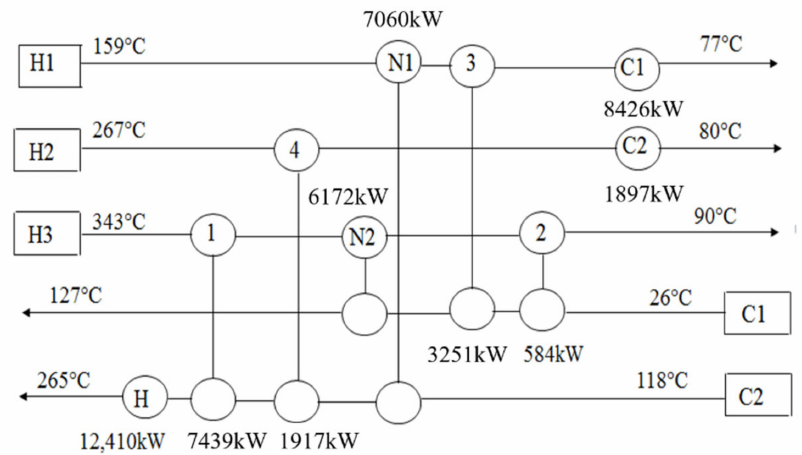
Figure 12. Best retrofit solution by applying PHE for case study